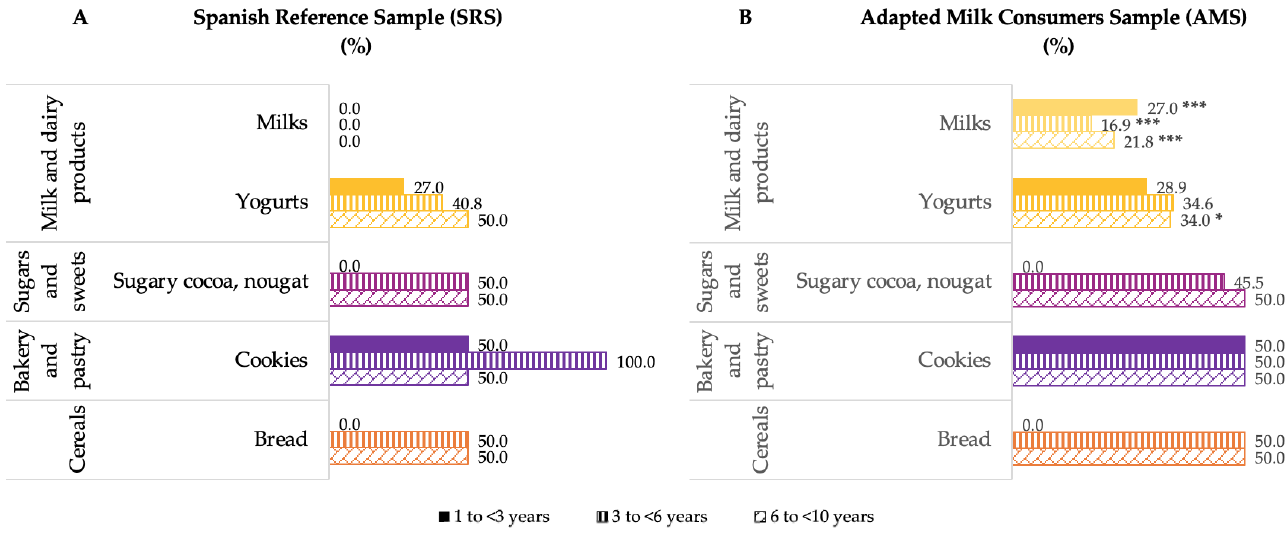
Figure 6. Bread and wheat flour, cookies, sugary cocoa, nougat, yogurts and milks subgroups contributing to added sugar intakes in cereals, bakery and pastry, sugars and sweets, and milk and dairy products groups (%) from the EsNuPI study population (“Spanish Pediatric Population”) in both the Spanish Reference Sample ( A ) and the Adapted Milk Consumers Sample ( B ) by age-group. * p ≤ 0.05 compared to reference sample (Mann–Whitney test). *** p ≤ 0.001 compared to reference sample (Mann – Whitney test).